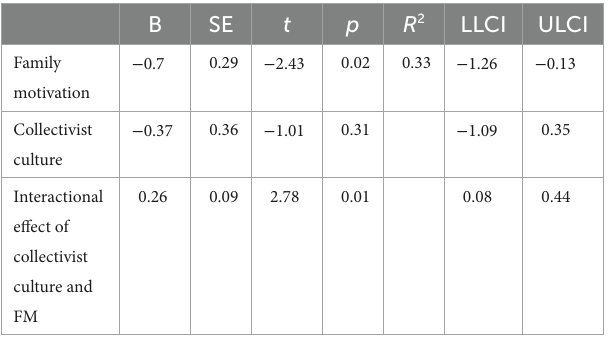
TABLE 4 Moderating effect of collectivist culture between family motivation and psychological